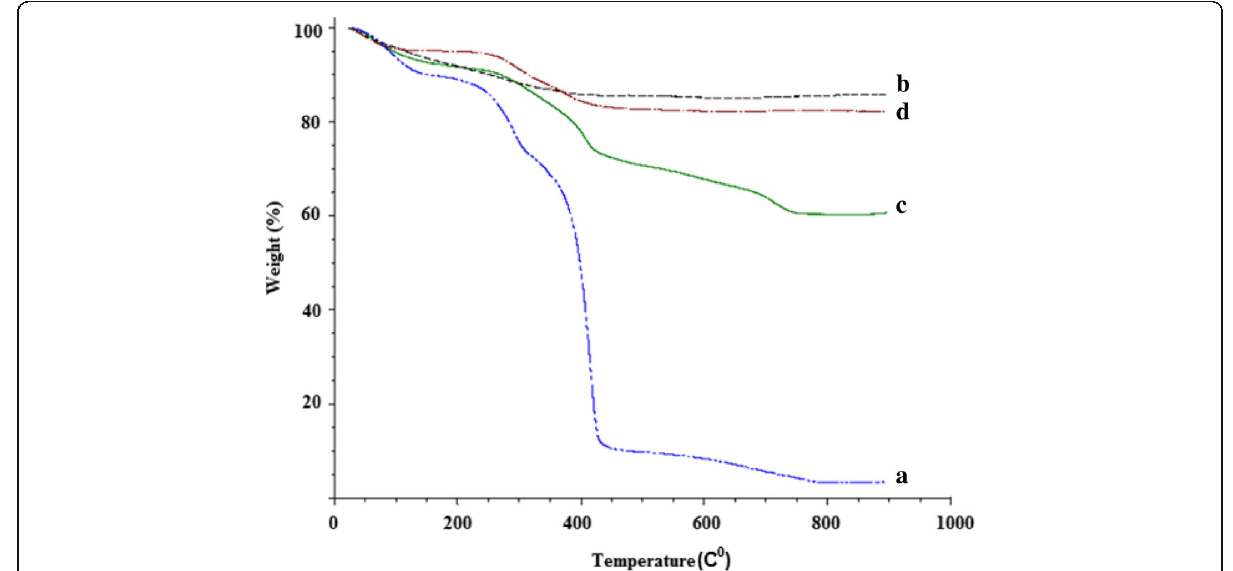
Fig. 2 Thermogravimetric analysis of PNIPAAm (a), Fe 3 O 4 -PNIPAAm-1 (b), Fe 3 O 4 -PNIPAAm-2 (c) and Fe 3 O 4 -PNIPAAm-3